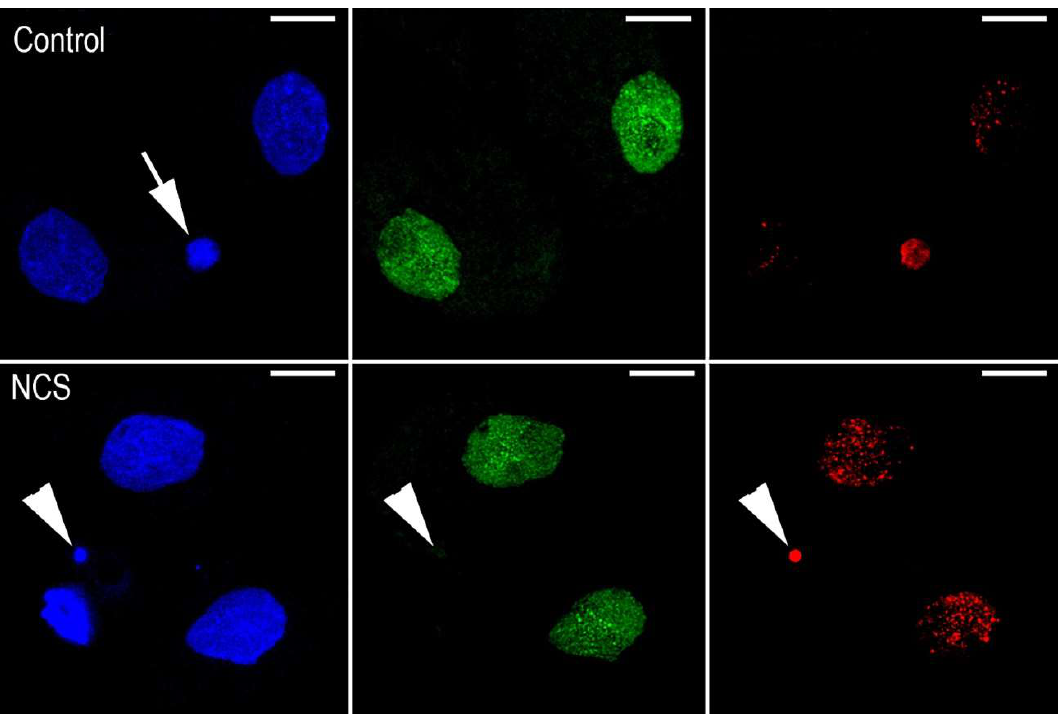
Figure 11. Double immunostaining of two-cell embryo after NCS treatment in the G1-phase of the one-cell stage. DAPI staining (blue) shows the nuclei and the micronucleus (arrowhead)positive for γ H2A.X Ser139 (red fluorescence—arrowhead). The green immunofluorescence documents the incorporation of EdU into DNA of the nuclei only, but not in the micronucleus (green fluorescence—arrowhead). Polar body in the control embryo stained with DAPI (arrow). Scale bar = 10 µm.